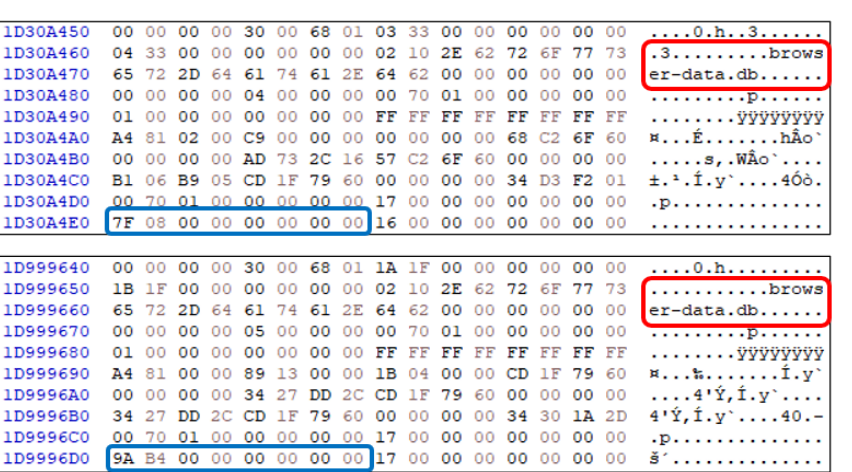
Figure 8. Catalog tree data structure in form of hex value.